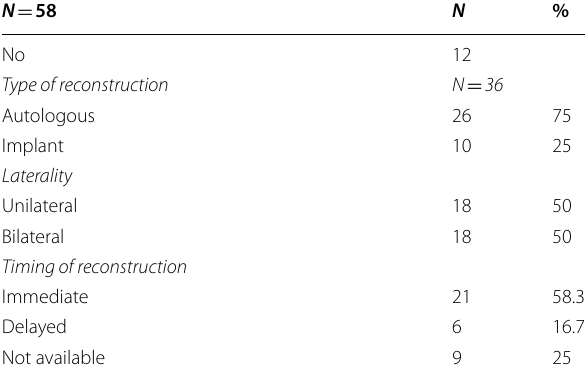
Table 1 Demographic and clinical characteristics of the